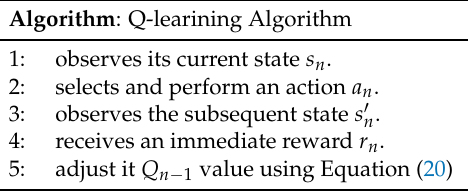
Figure 13. Controller structure for the proposed method (SLMIC). Table 2. Q-learning procedure for n th episode.